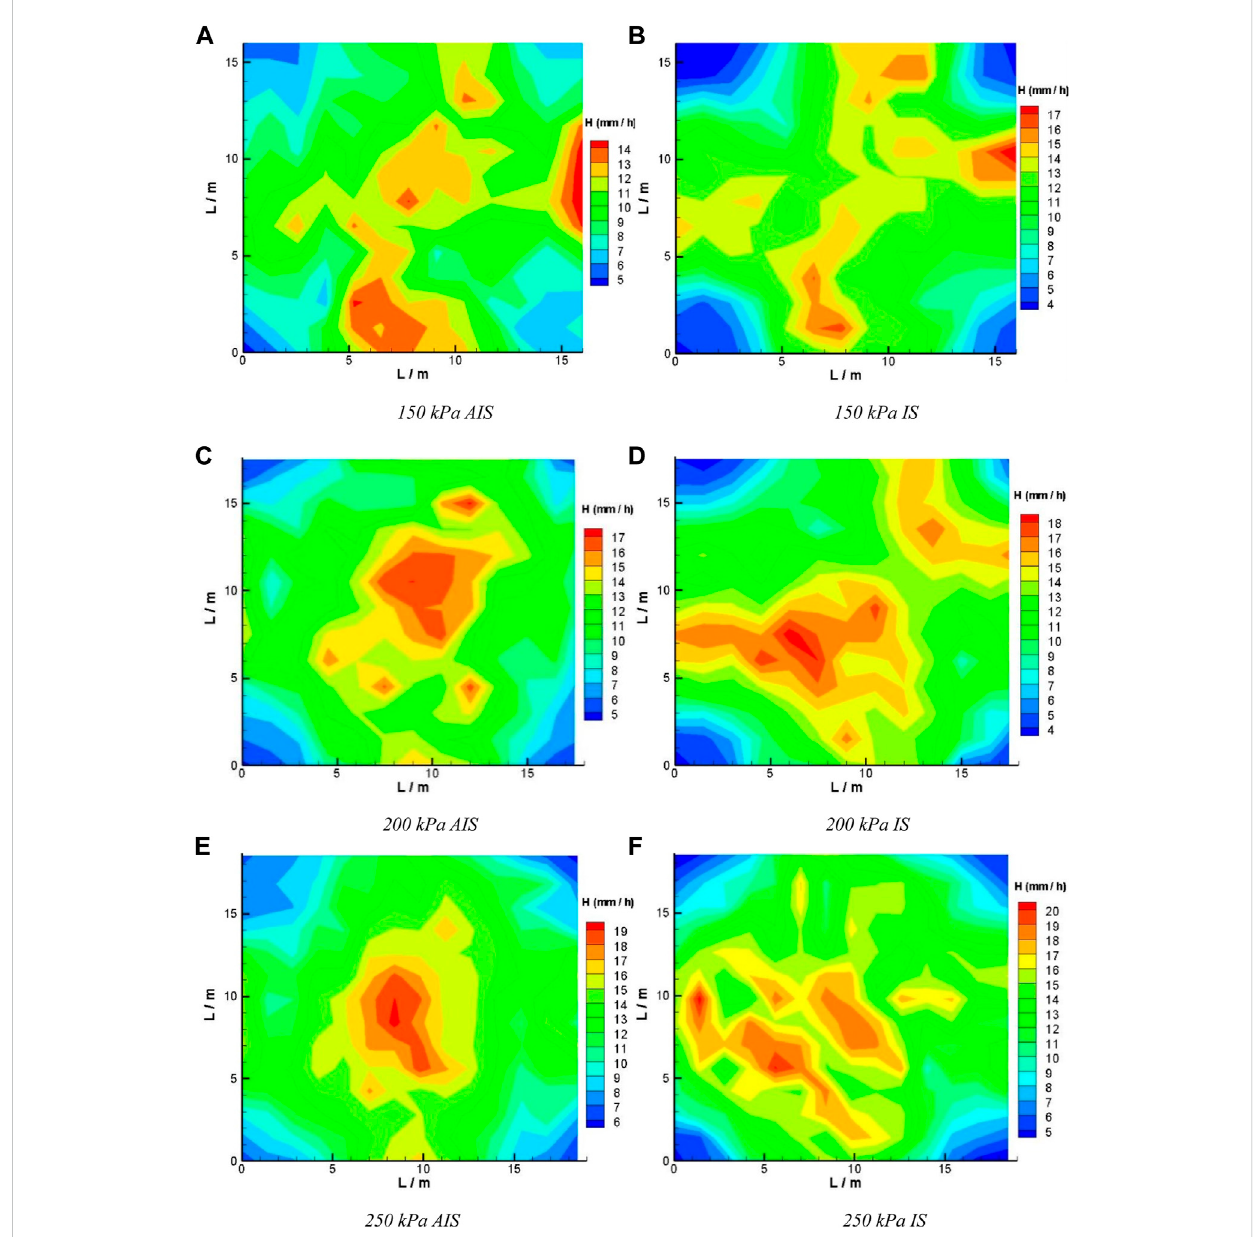
FIGURE 6 Contourmapoftheexperimentaldatawith1Rlateralspacingandatdifferentoperatingpressures.A,C,EfortheAISat150,200,and250 kPa,andB, D, and Ffor the IS atthe same pressure.AIS,aerationimpact sprinkler; IS, impact sprinkler. (A) : 150 kPa AIS (B) : 150 kPa IS (C) : 200 kPa AIS (D) :200 kPa IS (E) : 250 kPa AIS (F) : 250 kPa